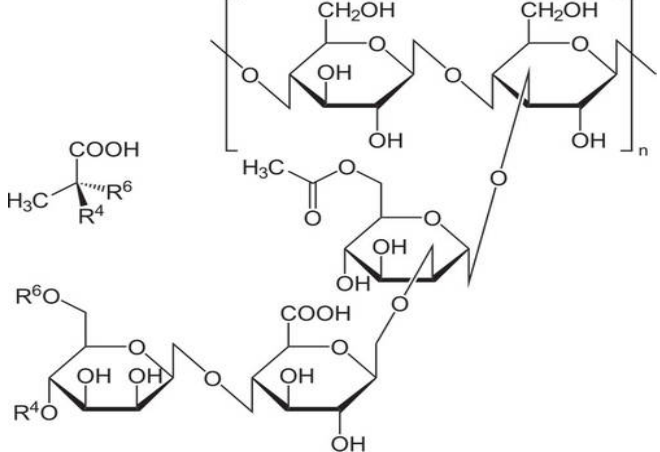
Figure 6. Structure of Xanthan gum